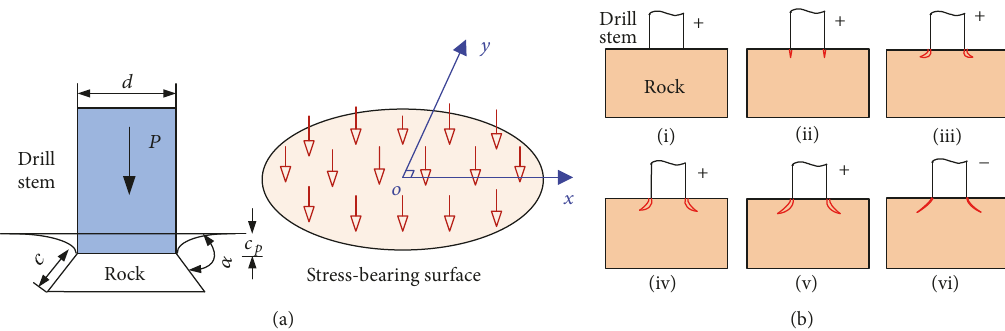
Figure 8: The interaction between the drill stem and the rock. (a) The load that the drill stem applies to the rock. (b) The formation and development process of Hertz cone cracks in the rock.